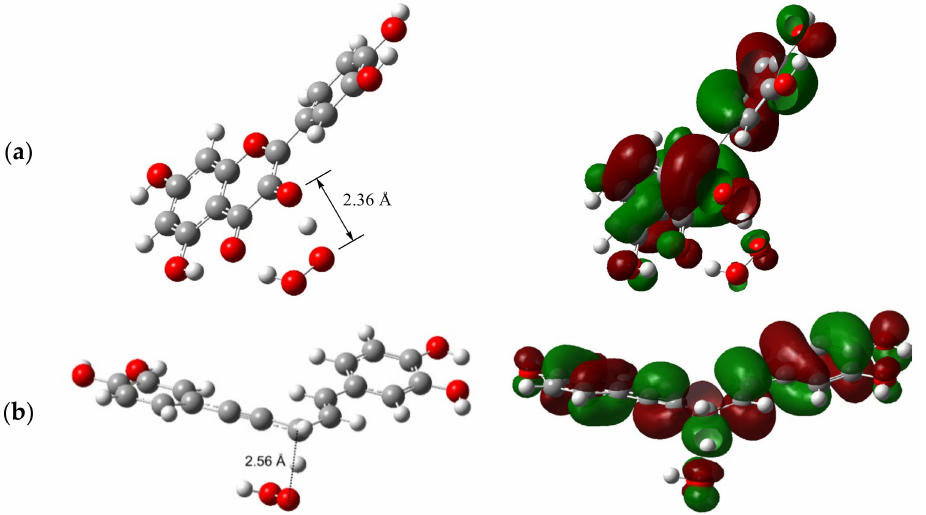
Figure 3. The TS structure accompanied by the corresponding SOMO for the reaction of: ( a )